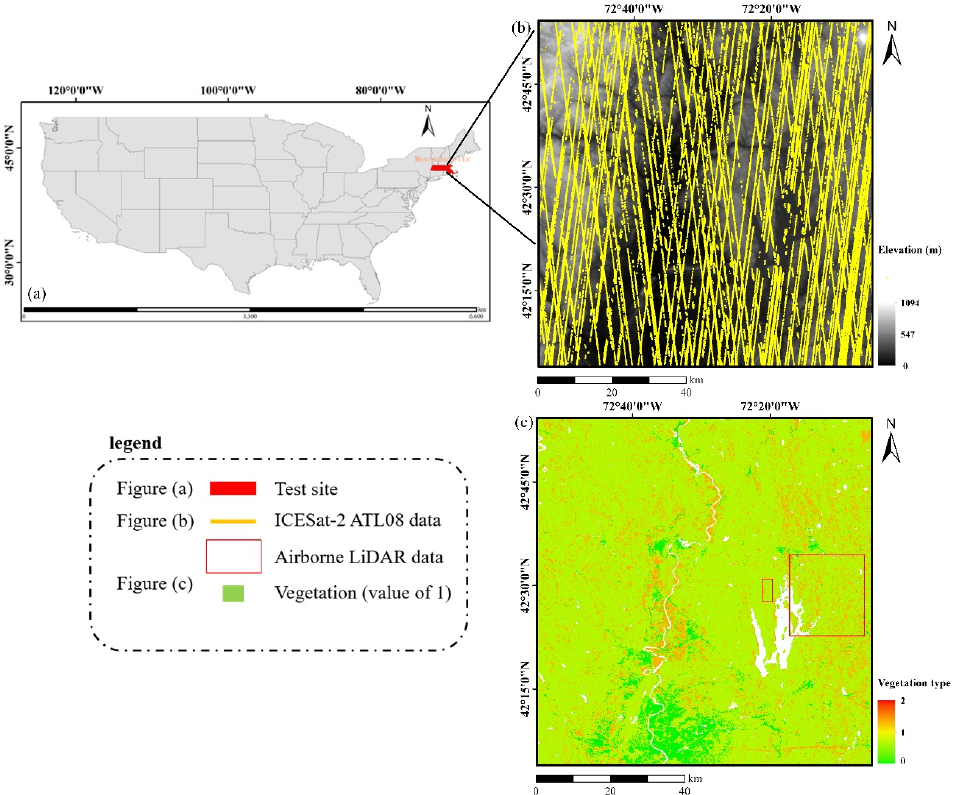
Figure 1. The test site and datasets: ( a ) the test site; ( b ) SRTM DEM and ICESat-2 ATL08 data; ( c ) vegetation classification data and airborne LiDAR